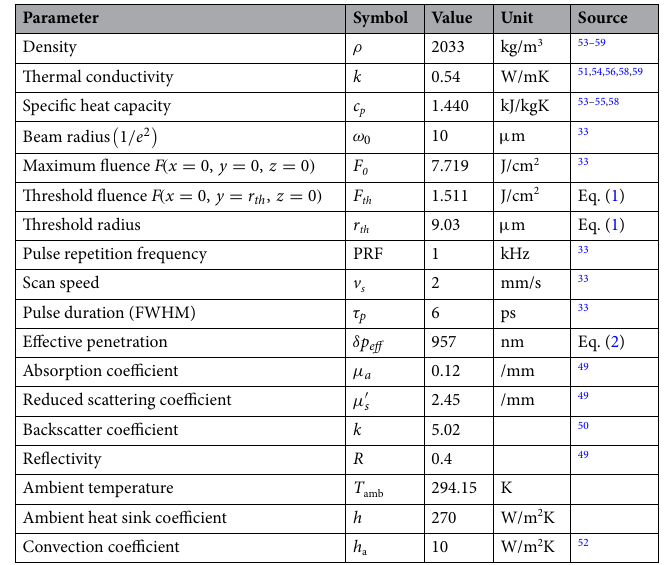
Table 1. Parameters used to model the laser-tissue interaction in Abaqus